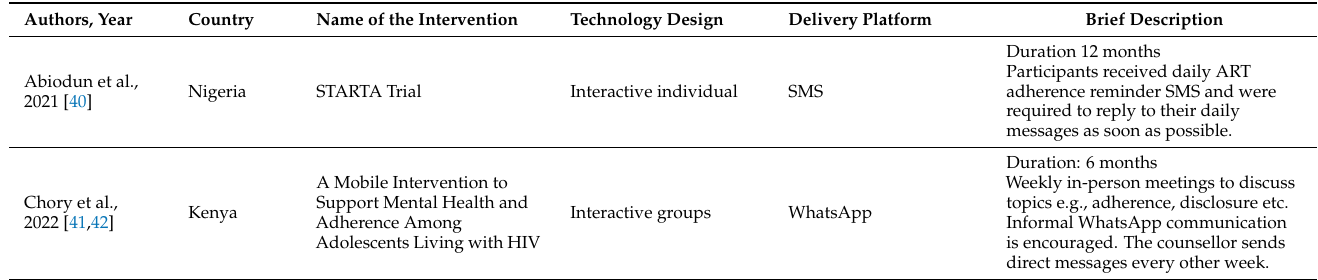
Table 4. Characteristics of technology-enabled